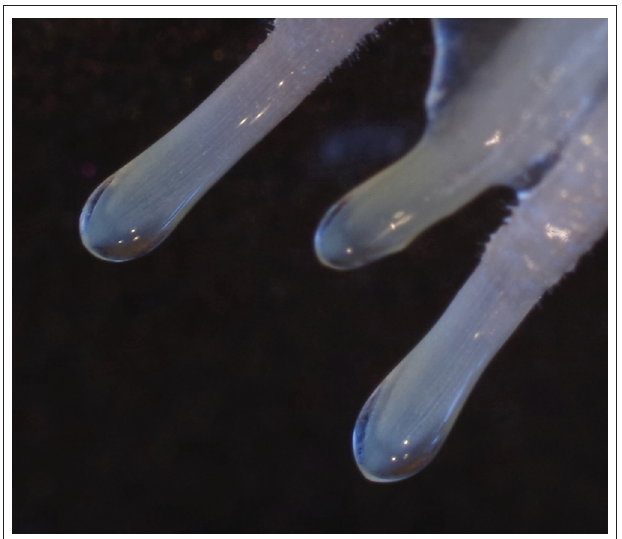
FIGURE 1 | Mucilage around the root tips of a 3 day old wheat seedling.